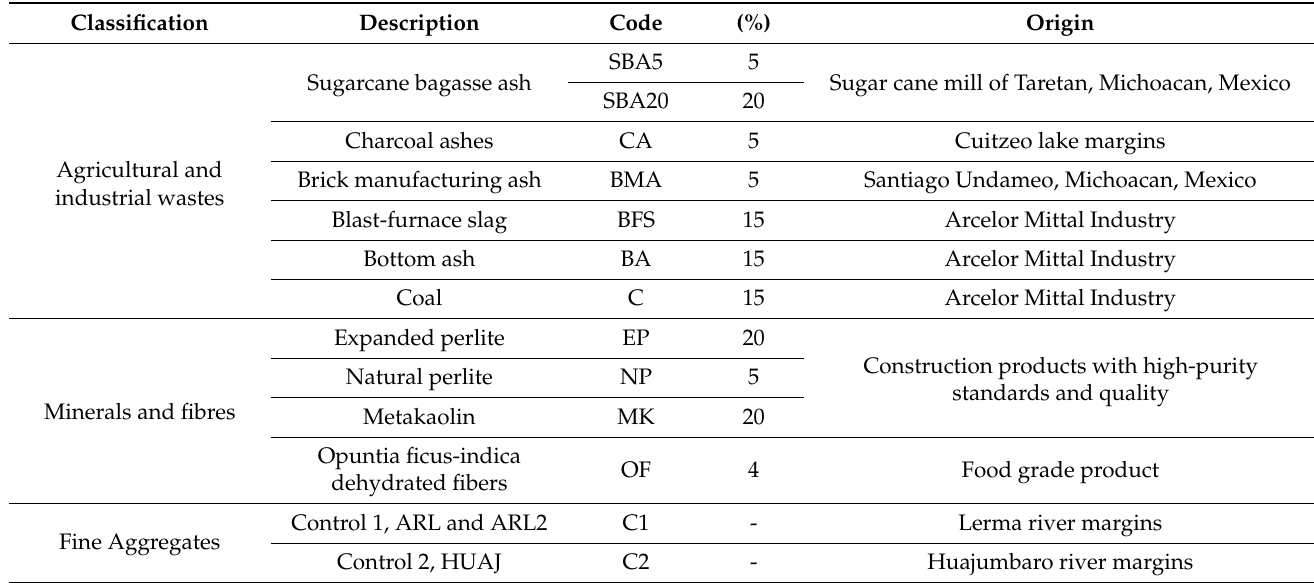
Table 1. Classification of the Portland cement substitutions.